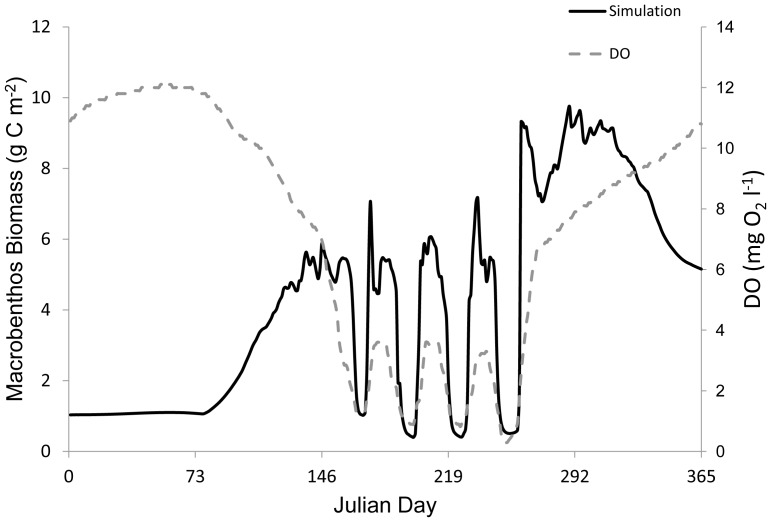
Simulations of intermittent hypoxic duration and macrobenthic response.Simulated macrobenthos biomass (B) under intermittent hypoxia (14 days hypoxic and 14 days normoxic) representing effect of neap/spring tide cycle. Left y-axis: the gray solid line represents modeled macrobenthos biomass and the black dots denote observed macrobenthos biomass from site LE3.4 of the Chesapeake Bay Benthic Monitoring Program in 1992. Right y-axis: the grey dashed line indicates the dissolved oxygen concentration on the right y-axis. B responded to modeled intermittent hypoxia.